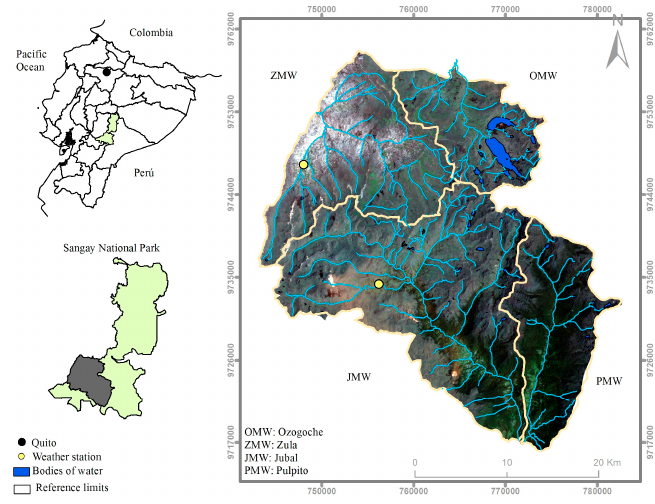
Figure 1. Map of the studied area.